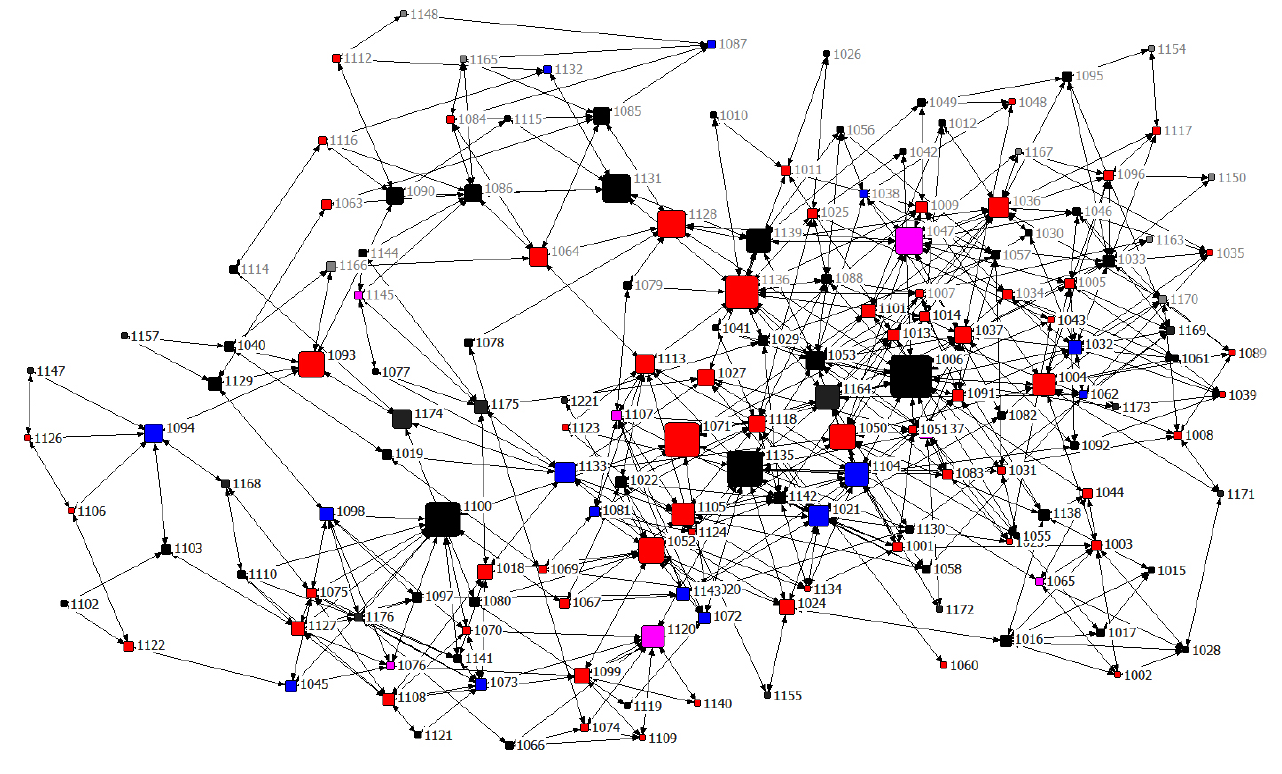
Fig. 8 . Labor Exchange Network where larger nodes have higher betweenness values and grayscale reflects number of adults in household (darker nodes have